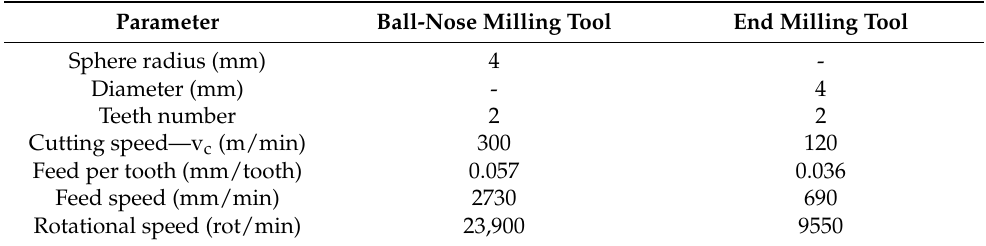
Table 1. Technical characteristics of the cutting milling tools used in the machining process.